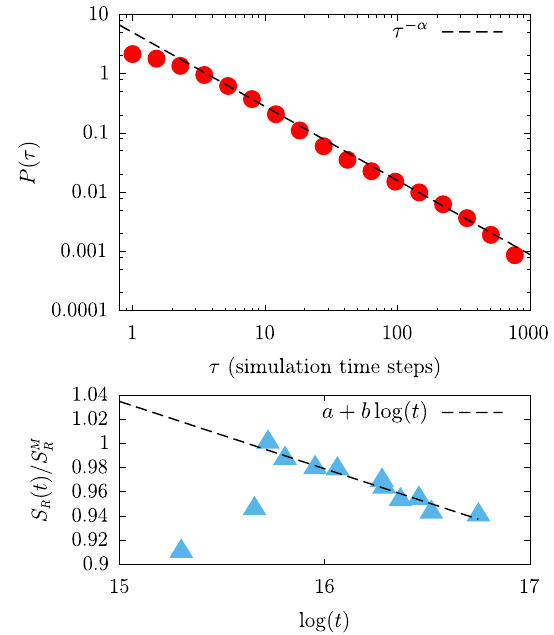
FIG. 10. Top panel: Probability distribution for the trapping time τ (in simulation time steps), i.e., the time spent in the solid state, at σ p = σ Y ≃ 1 . 4 . The distribution can be well fit by a power law P ð τ Þ ∼ τ − α , with α ∼ 1 indicating a self-similar structure in the intermittent transitions from the solid to the fluidized state. Such self-similar distribution has also been measured in spin glasses [34]. In the lower panel, we show the running average S ð t Þ of the shear S ð t Þ ¼ 2 π u ð t Þ =L , normalized to its maximum s R S M ð t Þ is consistent with a (see text for details). The behavior of S R R logarithmic